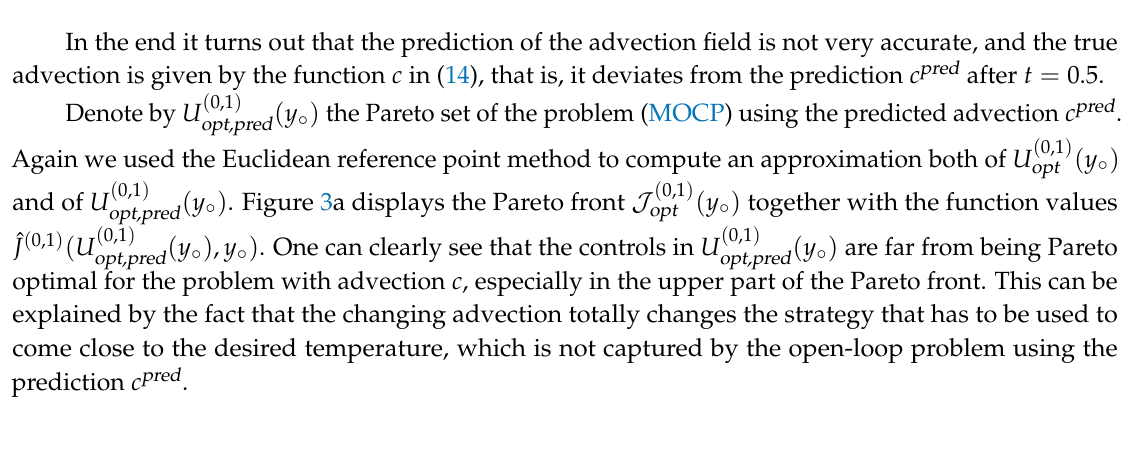
(cid:55)→ α end for different model predictive control (MPC) horizon 1 1